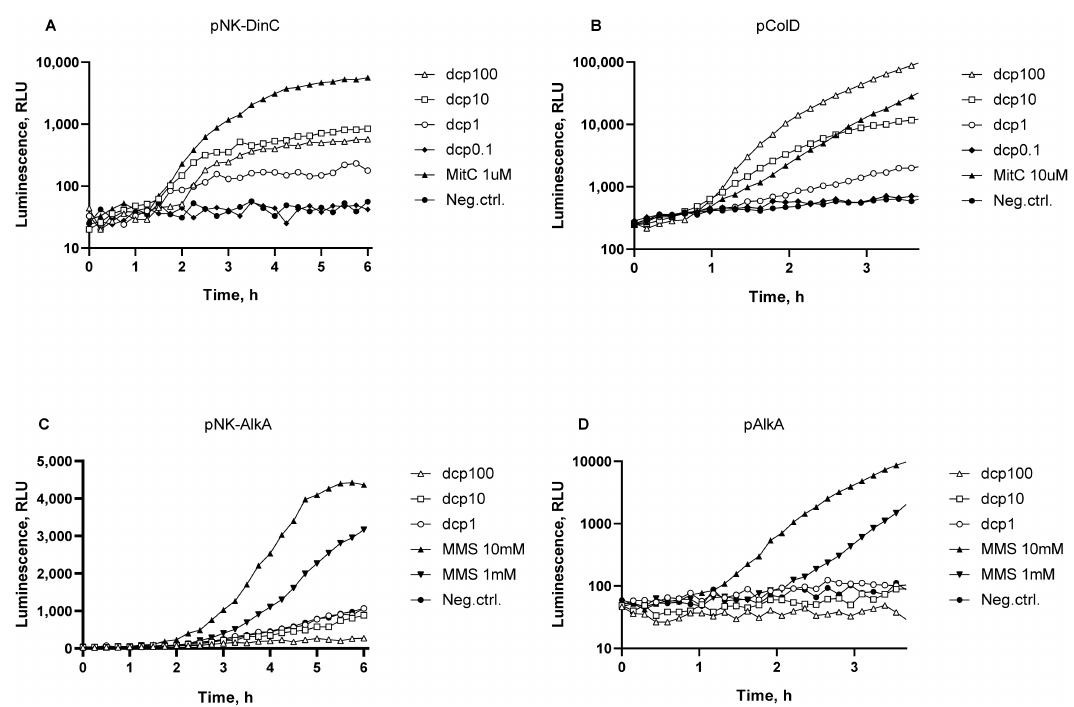
Figure 2. Typical kinetic curves of luminescence of B. subtilis 168 pNK-DinC ( A ), E. coli MG1655 pColD-lux ( B ), and B. subtilis 168 pNK-AlkA ( C ), E. coli MG1655 pAlkA-lux ( D ) cells after addition of dcpVNB. “Neg.ctrl.”—negative control, i.e., biosensor cells without addition of any toxicant; “MitC 1uM” and “MitC 10uM” – mitomycin C added to a final concentration of 1 µ M and 10 µ M, respectively; “MMS 10mM”, “MMS 1mM”—MMS added to final concentrations of 10 or 1 mM, respectively; “dcp100”, “dcp10”, “dcp1” and “dcp0.1”—dcpVNB added to final concentrations of 100, 10, 1, or 0.1 mg/mL,